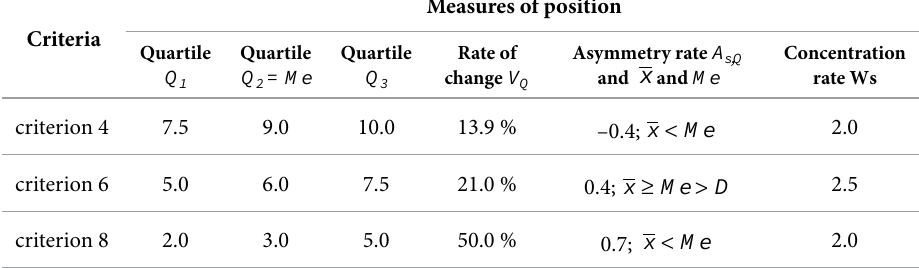
Table 3. Values of measures of position of data set calculated based on the criteria chosen